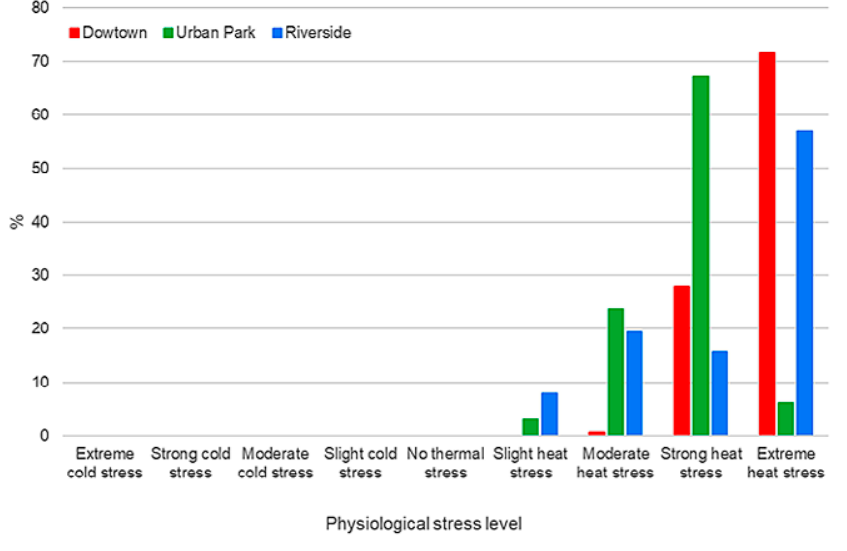
Figure 9. Frequency analysis (%) of different grades of physiological stress (based on PET values)